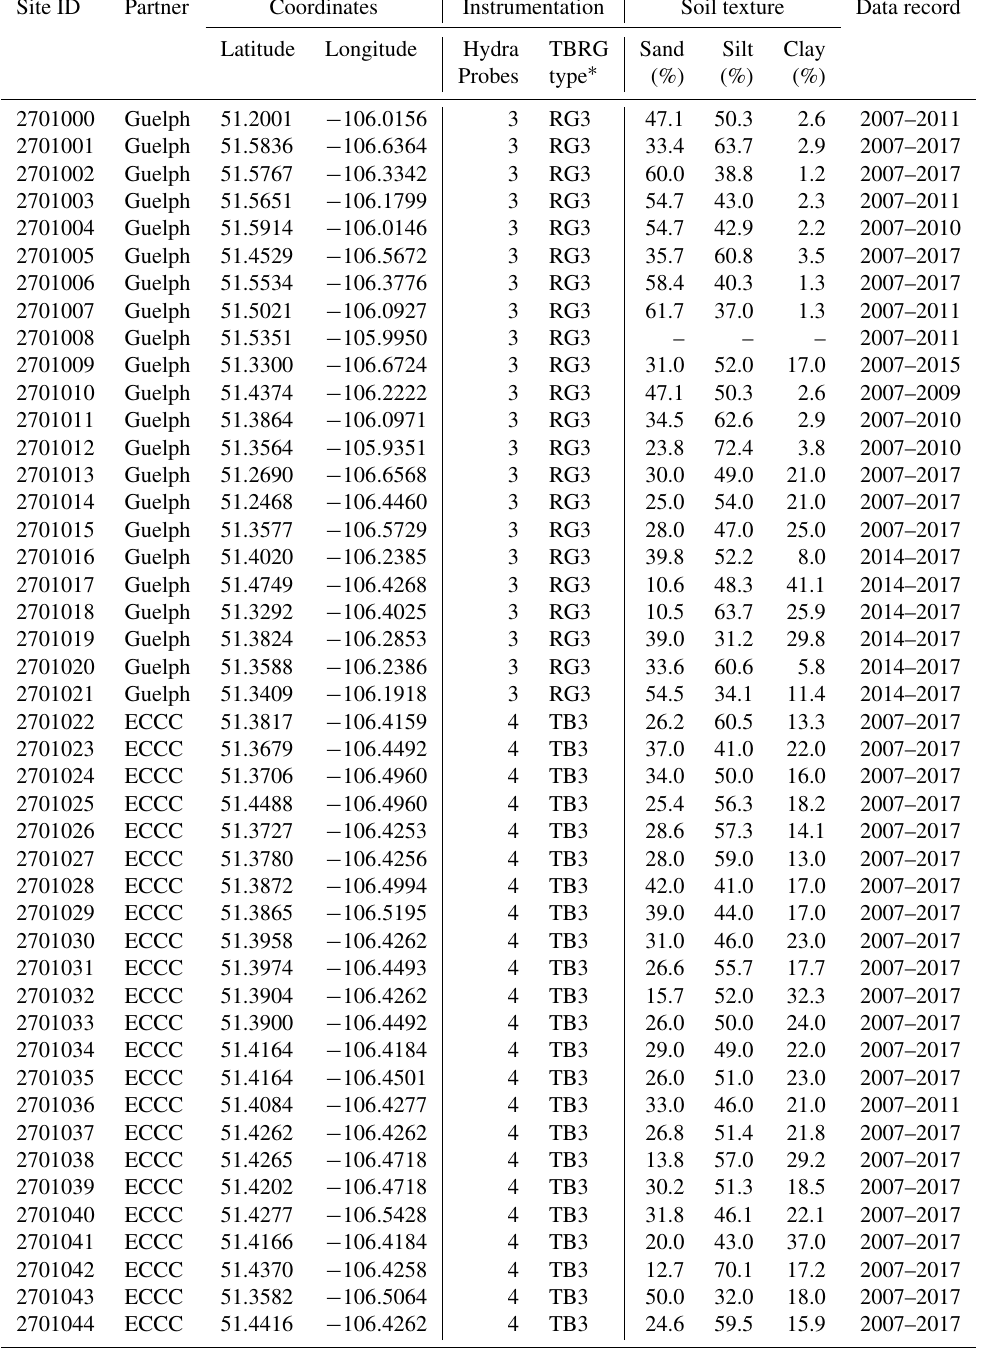
Table 1. Site metadata details including soil texture